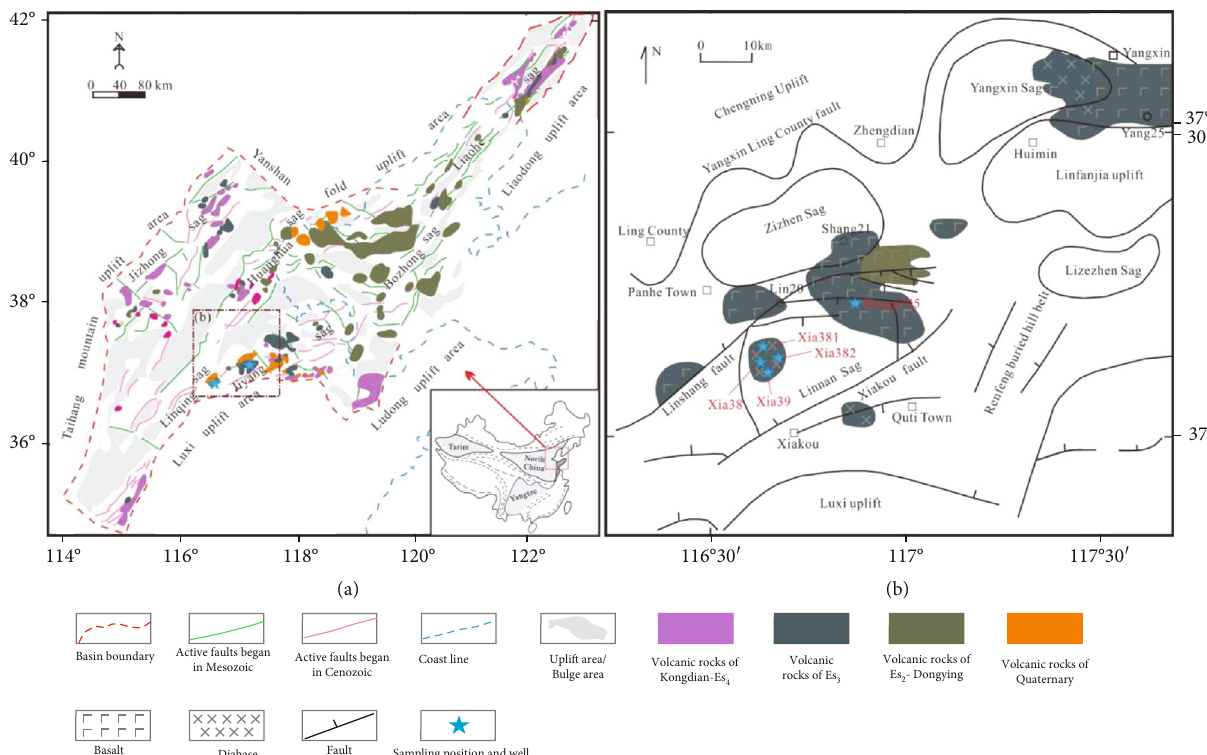
Figure 1: (a) Distribution of Cenozoic igneous rocks in the Bohai Bay Basin [55]. (b) A simpli fi ed structural map of the Huimin